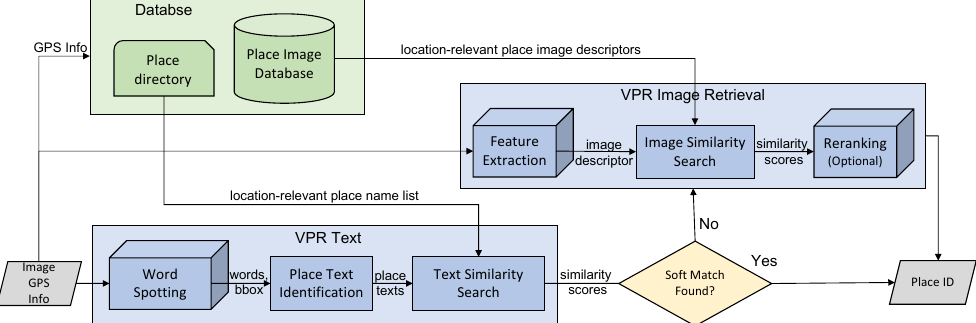
Figure 3. Proposed VPRTextImage architecture, comprising both text spotting and image retrieval modules. Given the query image and approximate location, VPR through text reading is attempted, if unsuccessful (i.e., no matching place names or no text detections) VPR through image-retrieval is attempted. Positioning information is used to narrow down the retrieval space. (In the diagram, cuboids represent the usage of deep learning-based